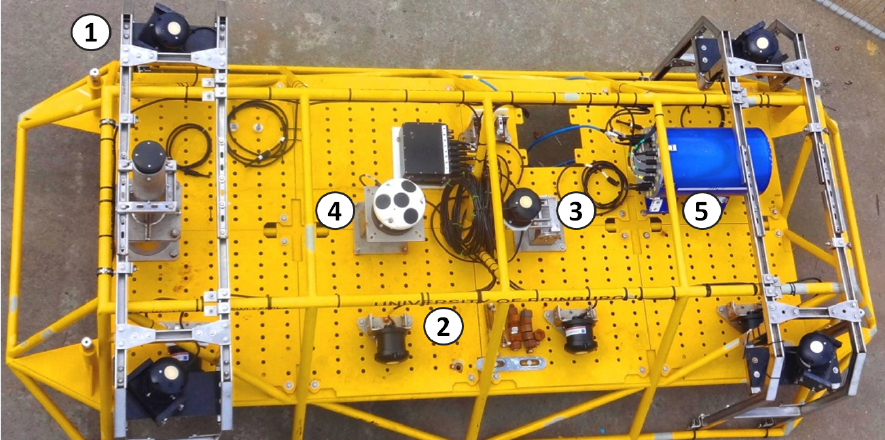
Figure 4. Photograph of ESIP-1 showing: (1) the Converging Acoustic Doppler Profiler (C-ADP) system; (2,3) horizontally- and vertically-orientated SB-ADPs; (4) vertically-orientated D-ADP; (5) electronics’ subsea